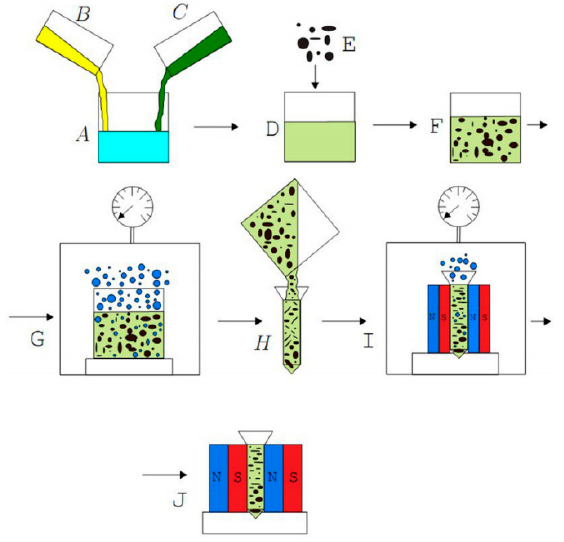
Figure 15. Preparation process of magnetostrictive composites.